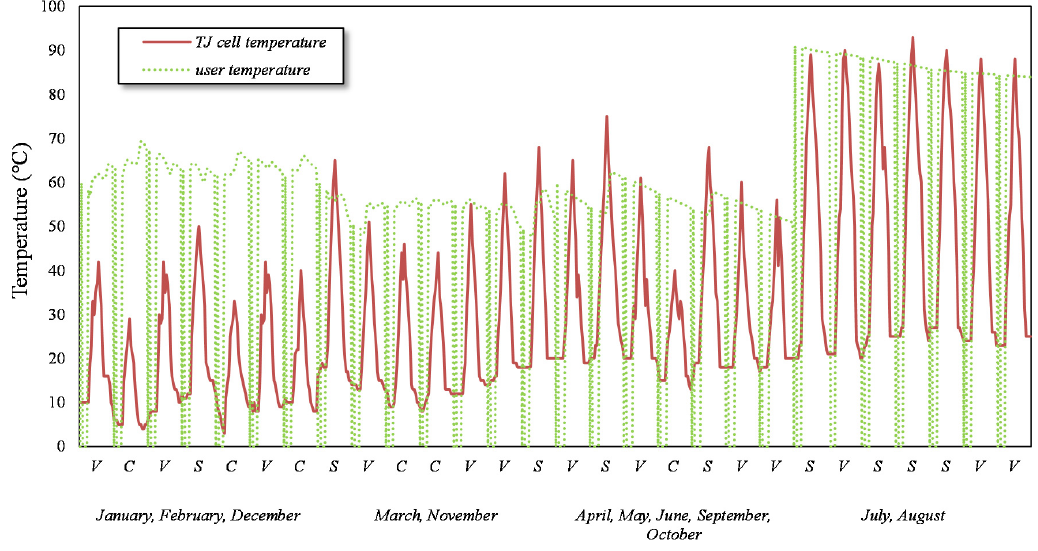
Figure 11. Comparison between TJ cell and user temperatures.